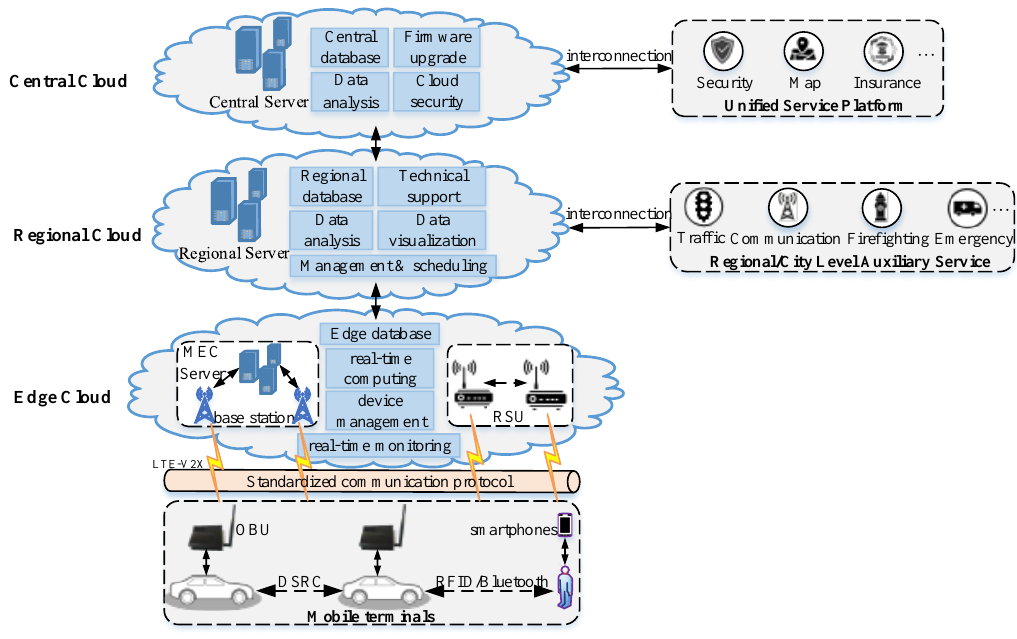
Figure 16. The cloud platform of the extended CWS. The regional cloud provides information along with regional level auxiliary services for transportation and communications. The regional cloud analyzes vehicle and pedestrian data in the database, intersection data with collision behaviors for management, and the scheduling of regional service